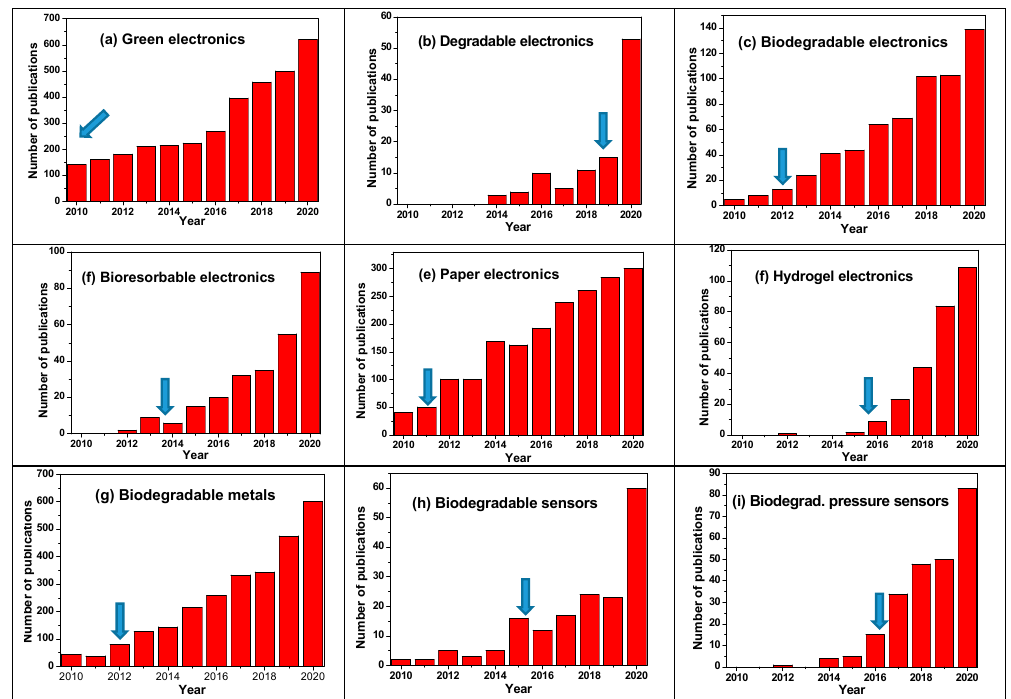
Figure 44. Histograms showing the progress, in terms of publication numbers which use ( a ) green ( e ) paper electronics, ( f ) hydrogel electronics, ( g ) biodegradable metals, ( h ) biodegradable sensors and ( i ) biodegradable pressure sensors. The blue arrow indicates when the publication rate starts to increase significantly.